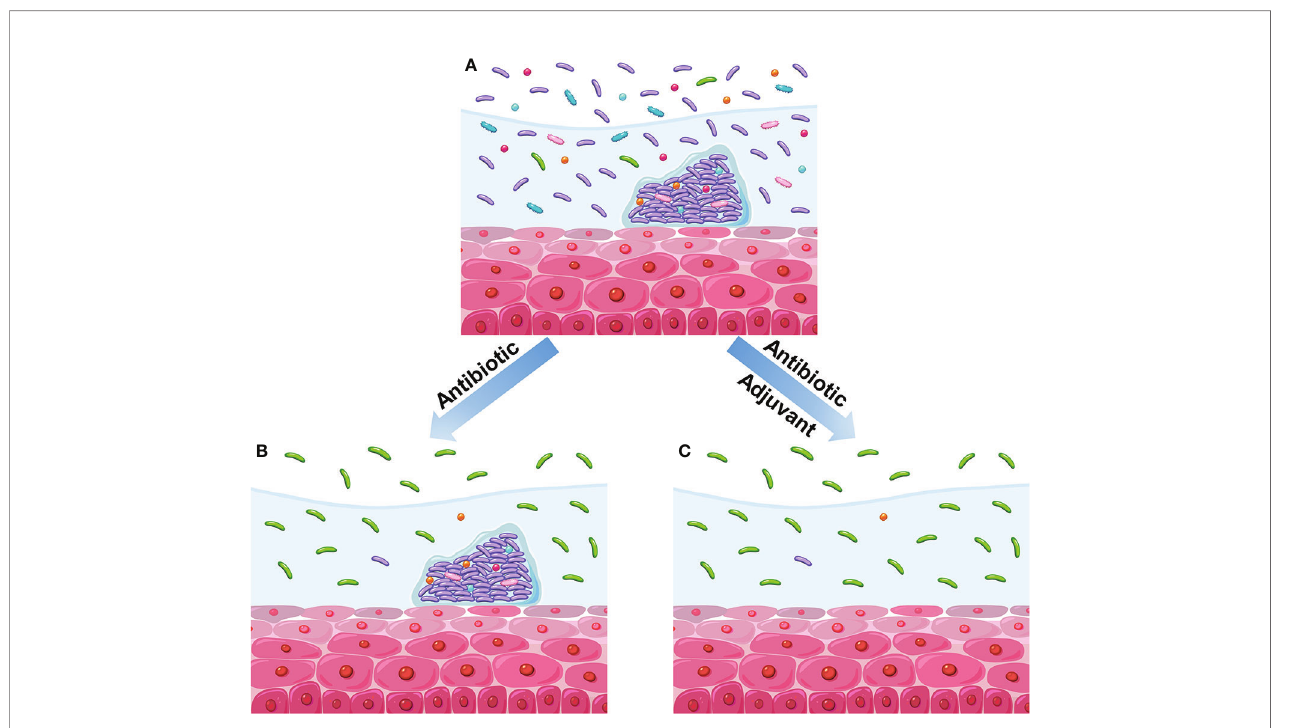
FIGURE 2 | Diagram of the impact of different therapeutic regimens on vaginal microbiome. (A) BV vaginal microbiome before treatment. This vaginal microbiome refers to high diversity of microbial community dominated by anaerobic bacteria instead of Lactobacillus . Meanwhile, the polymicrobial bio fi lms are formed on vaginal epithelium. (B) Treatment with antibiotics alone reduces the microbial diversity and causes the recovery of Lactobacillus population, but the bio fi lms have not been disrupted. (C) Treatment with antibiotics and adjuvant reduces the microbial diversity and causes the recovery of Lactobacillus population; moreover, the bio fi lms have been